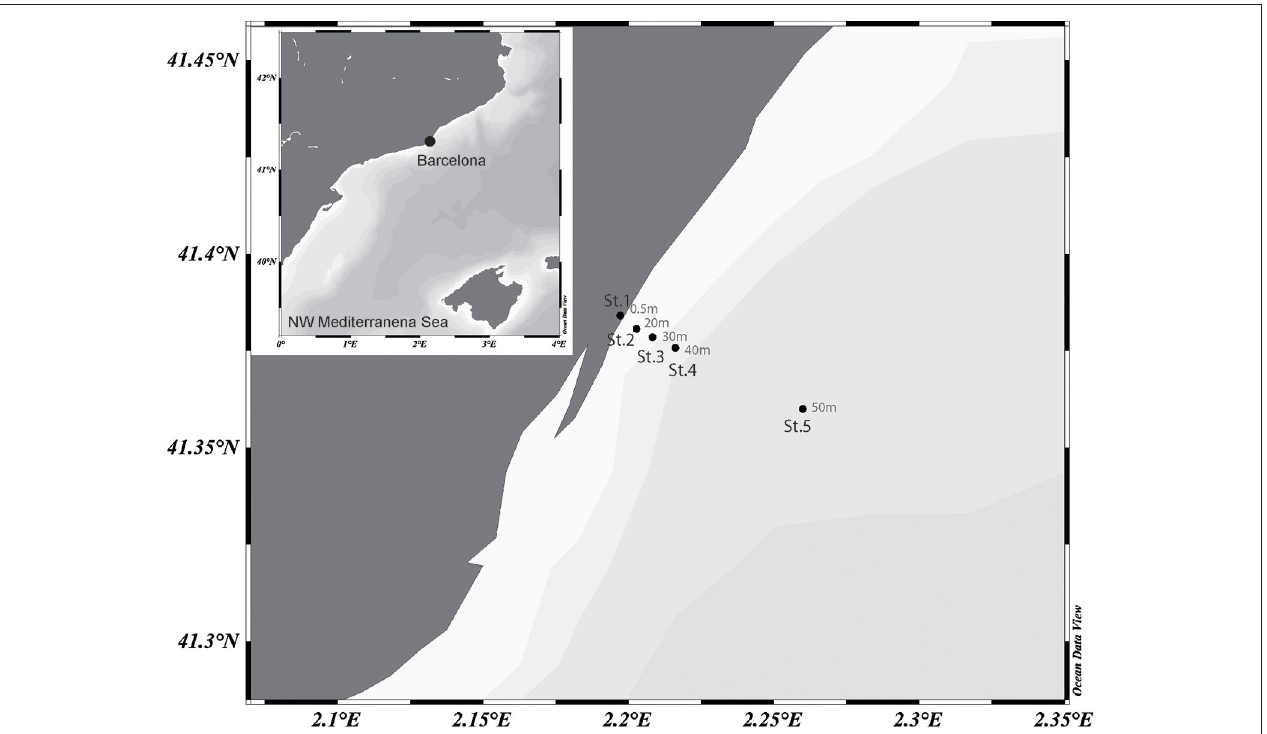
FIGURE 1 | Map showing the transect sampled off the coast of Barcelona in the NW Mediterranean Sea. Station location and depths (m) are indicated. The map was generated with the Ocean Data View Software (https://odv.awi.de).